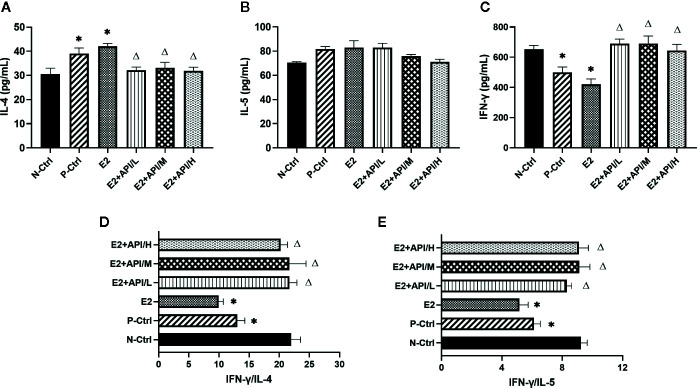
API worked on Th cells to modulate the Th1/Th2 subsets balance. (A) Concentration of IL-4, (B) IL-5 and (C) IFN-γ in serum. (D) The ratio of IFN-γ and IL-4, (E) IFN-γ and IL-5. Data are presented as the mean ± SEM from 10 mice. *P < 0.05 as compared to the N-Ctrl group, △P < 0.05 as compared to the E2 group.